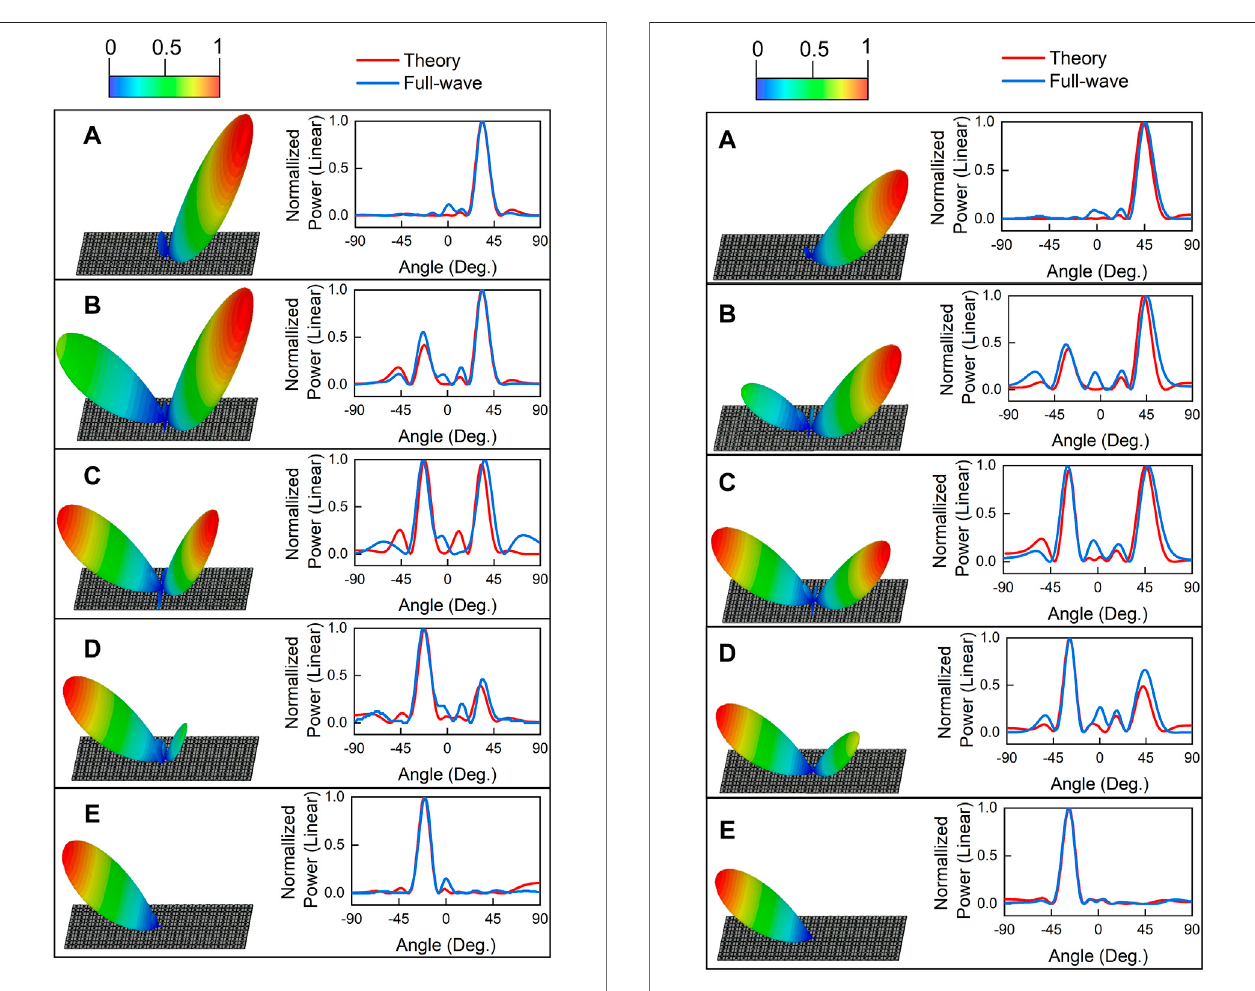
FIGURE 7 | The 3D scattering patterns of dual beams pointing at -27 ° and 47 ° simultaneously, with power intensity ratios of (A) 0:1 (B) 0.5:1 (C) 1: 1 (D) 1: 0.5 (E) 1:0 and their corresponding 2D scattering patterns.